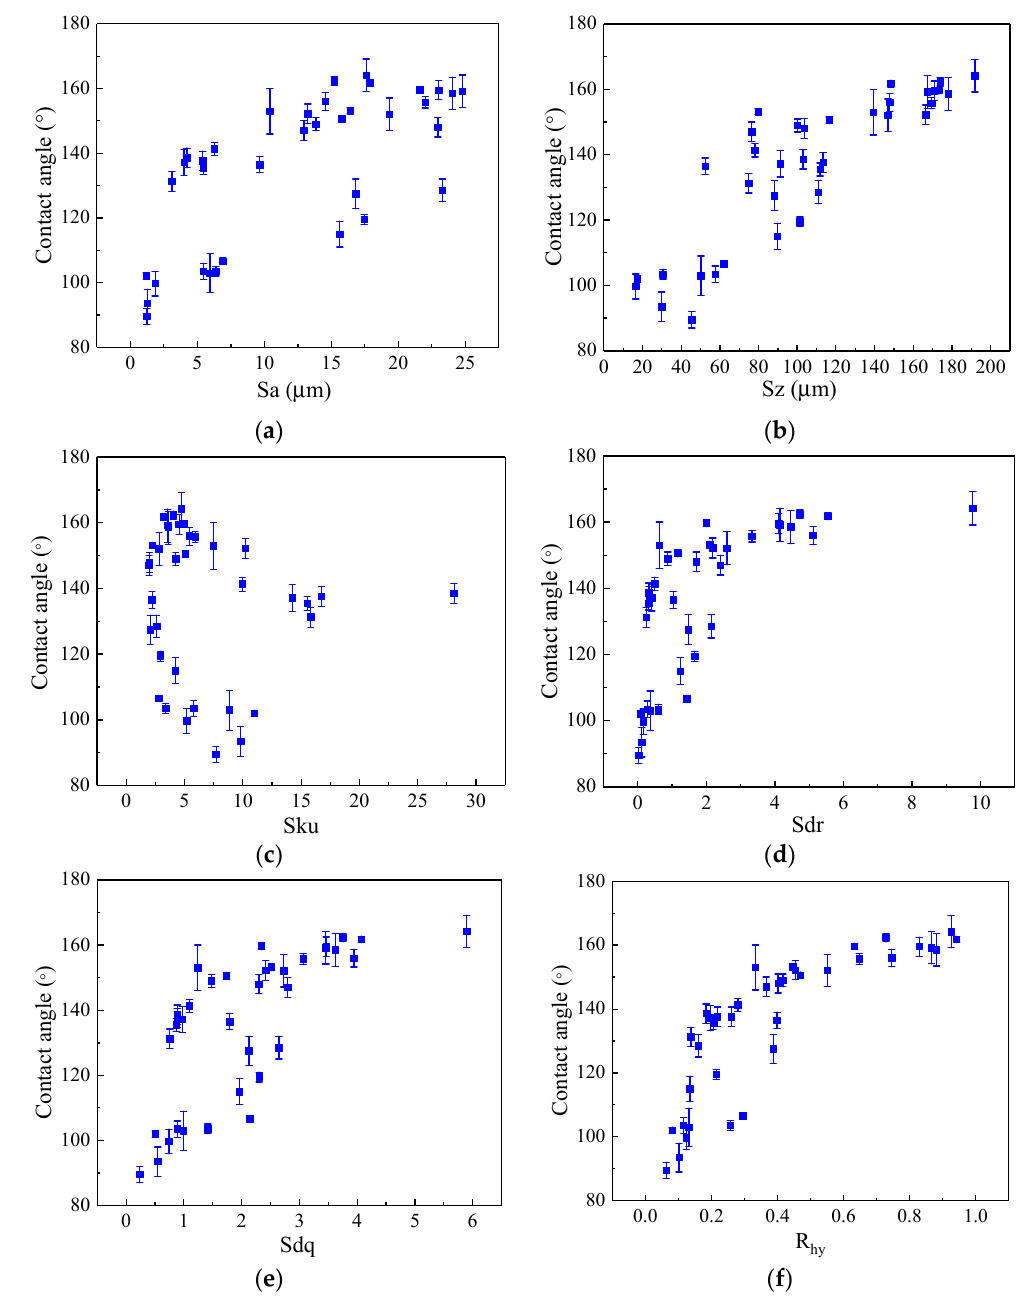
Figure 4. Influence of the product fingerprint candidates on the contact angle for Gaussian hole pattern: ( a ) Sa; ( b ) Sz; ( c ) Sku; ( d ) Sdr; ( e ) Sdq; ( f ) R hy .